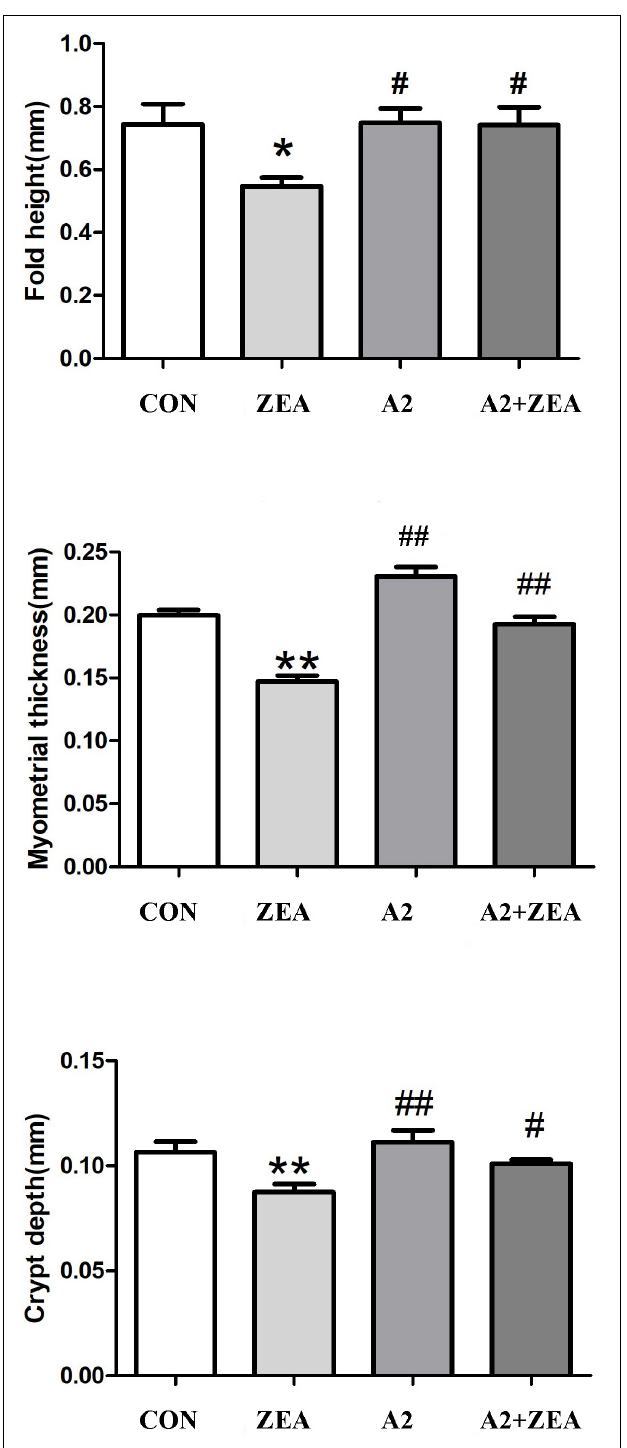
FIGURE 2 | Measured fold height, myometrial thickness, and crypt depth of mice in each group. “*” denotes a significant difference compared with the CON group ( P < 0.05), and “**” denotes an extremely significant difference compared with the CON group ( P < 0.01). “#” represents a significant difference compared with the ZEA group ( P < 0.05), “##” refers to an extremely significant difference compared with the ZEA group ( P < 0.01).